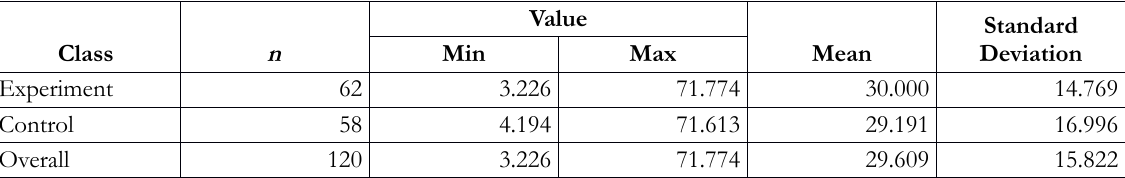
Table 1. Descriptive Statistic of Pre-Service Mathematics Teachers’ Mathematical Initial Ability